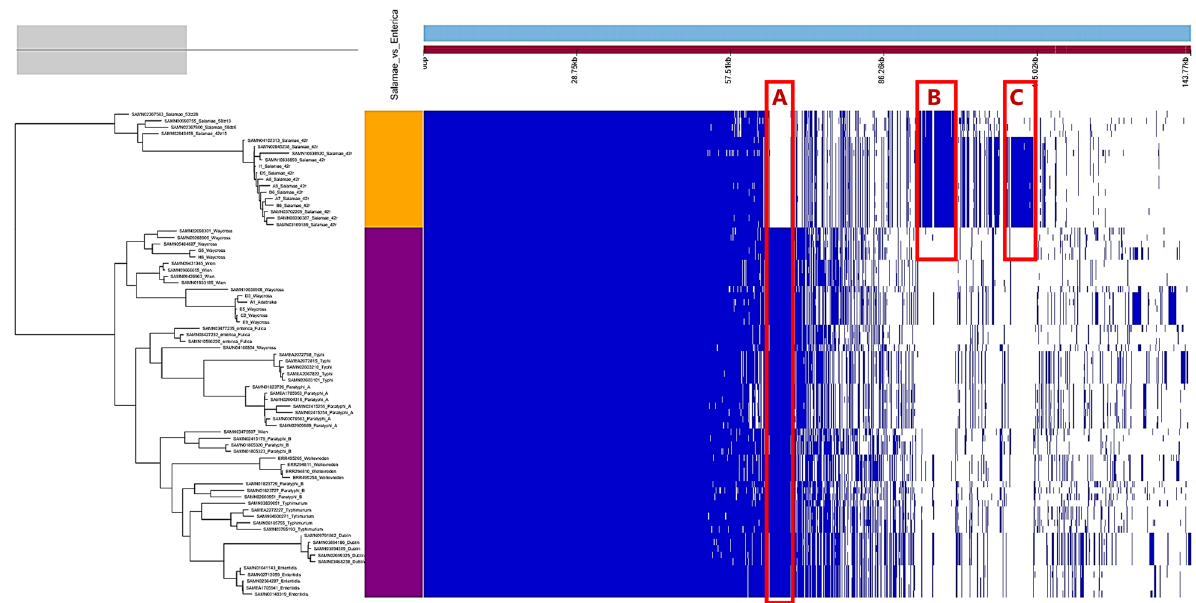
Figure 2. Pangenome view of 75 non- enterica and enterica subspecies of Salmonella enterica. All S . Salamae strains are in the clade colored orange while all subspecies enterica are colored purple. Unique coding sequences observed in the accessory genome are represented by the zones A, B and C.